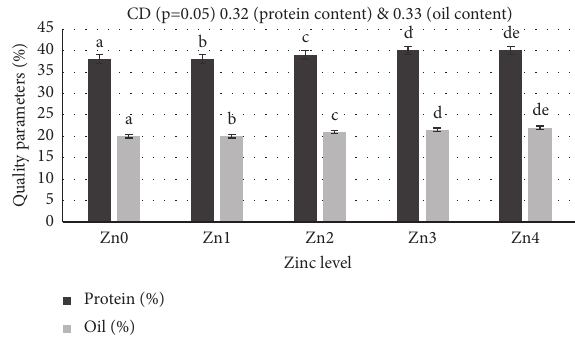
Figure 2: Effect of zinc on protein and oil content of soybean crop. Note. Four doses of Zn at the rate, 0kg/ha, 3kg/ha, 4kg/ha, and 5 kg/ha were assigned as Zn0, Zn1, Zn2, Zn3, and Zn4, respectively, and their effects on protein and oil composition. The figure is adapted from